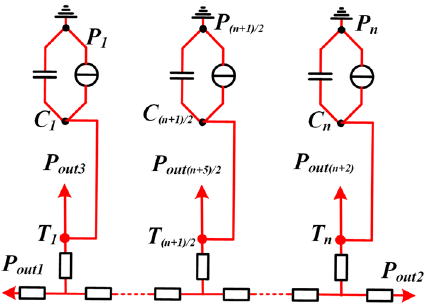
Figure 4. Thermal network model with n T-equivalent network circuit of GMM